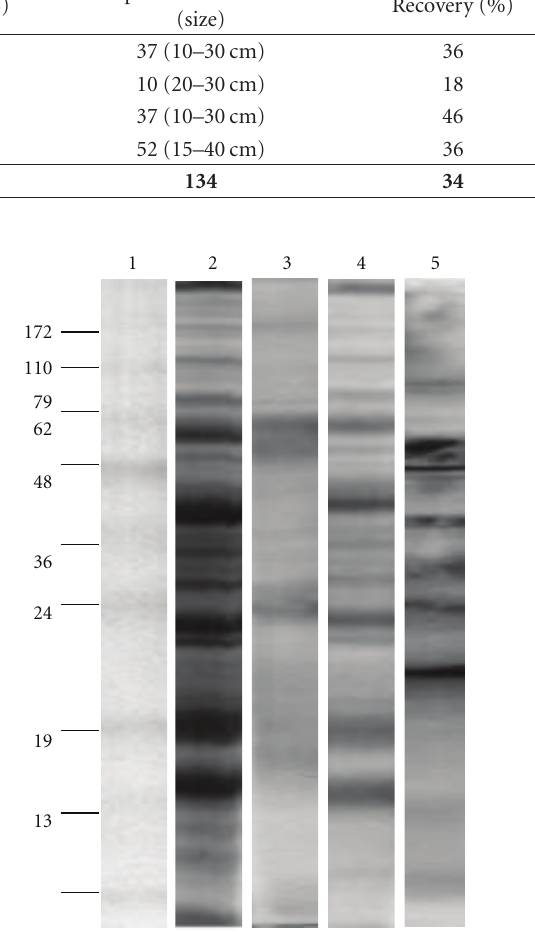
Figure 1: 10% SDS-PAGE. Lane 1: molecular weights (Bench- Mark prestained protein ladder, Invitrogen), and Taenia solium . Lanes 2: tapeworm crude extract (CE), Lane 3: tapeworm